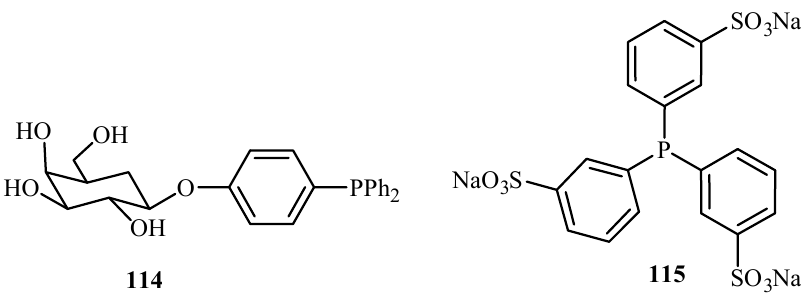
Figure 12. Ligands reviewed by Zapf and Beller [26].